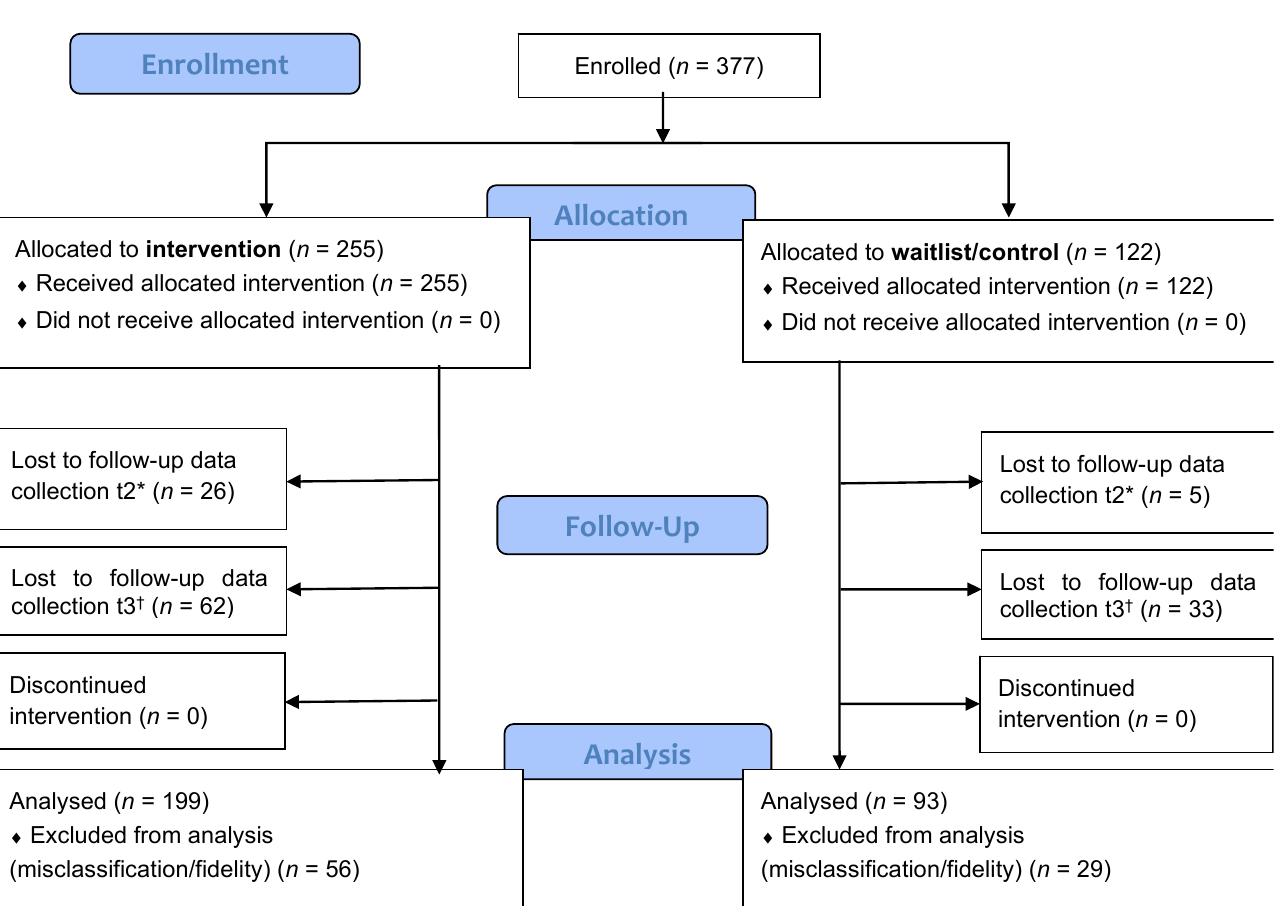
Figure 2. Modified CONSORT flow diagram [54].